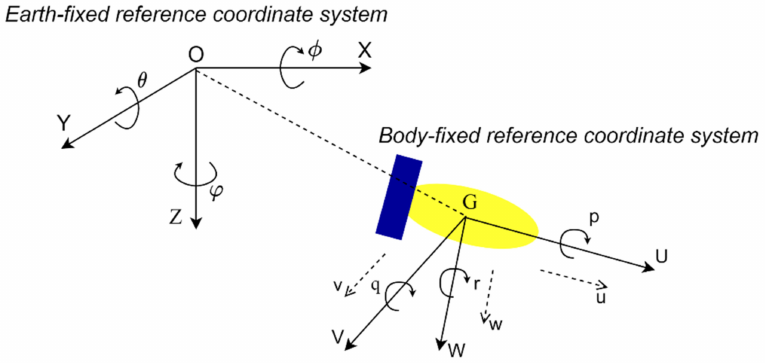
Figure 2. Earth-fixed reference coordinate system and body-fixed reference coordinate